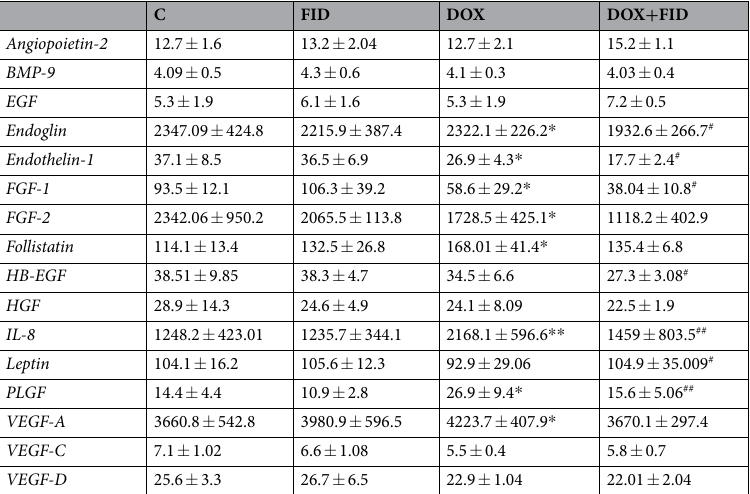
Table 1. Inflammatory cytokines in HT-29 xenograft tumors. Expression of inflammatory cytokines in HT-29 xenograft tumors in nude mice after 21 days of treatment with DOX (4 mg kg − 1 wk − 1 i.p) alone or in combination with fidarestat in drinking water (25 mg kg − 1 ). The tumors were homogenized in MILLIPLEX MAP Lysis Buffer and analyzed by using a human inflammatory cytokine/chemokine magnetic bead panel (Milliplex MAP Kit) using a Millipore Milliplex analyzer system. Values are Mean ± SD. Samples were analyzed in triplicates. (n = 6 in each group). * p < 0.01 vs Control; ** p < 0.001 vs Control; # p < 0.01 vs DOX; ## p < 0.001 vs